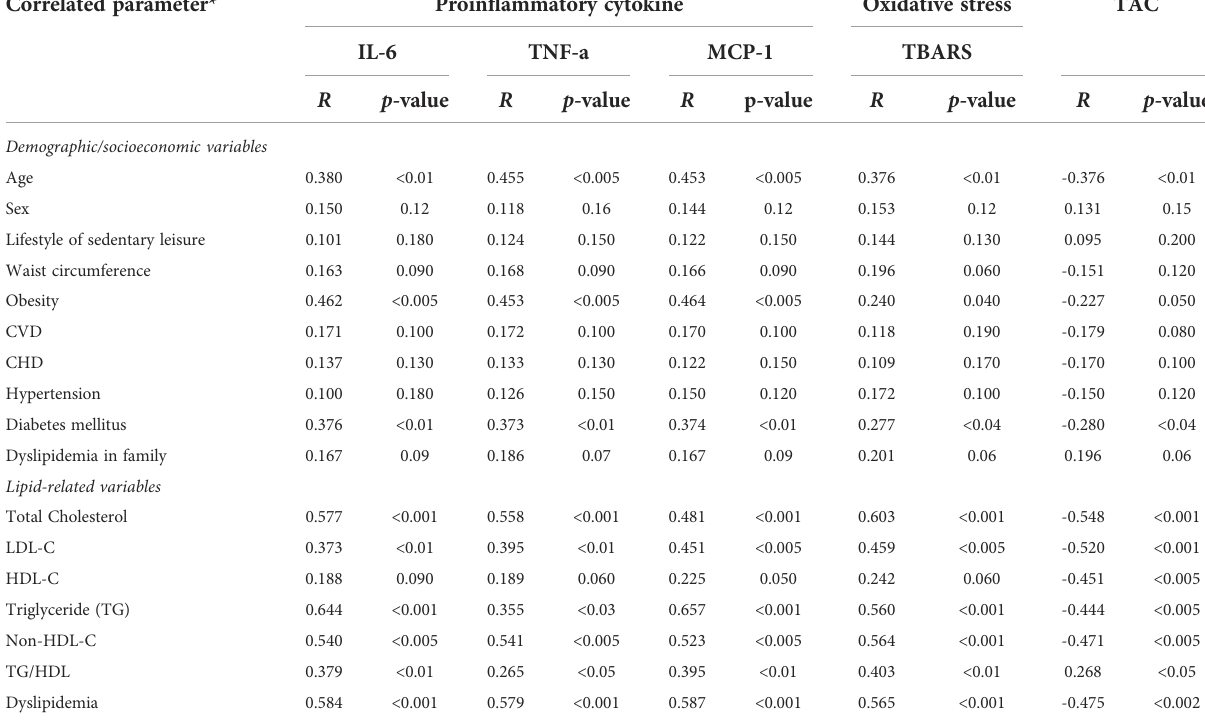
TABLE 7 Correlation of the serum proin fl ammatory cytokines, oxidative status, and antioxidant capacity with relevant parameters among adults in East Coast, Fujian, China. Correlated